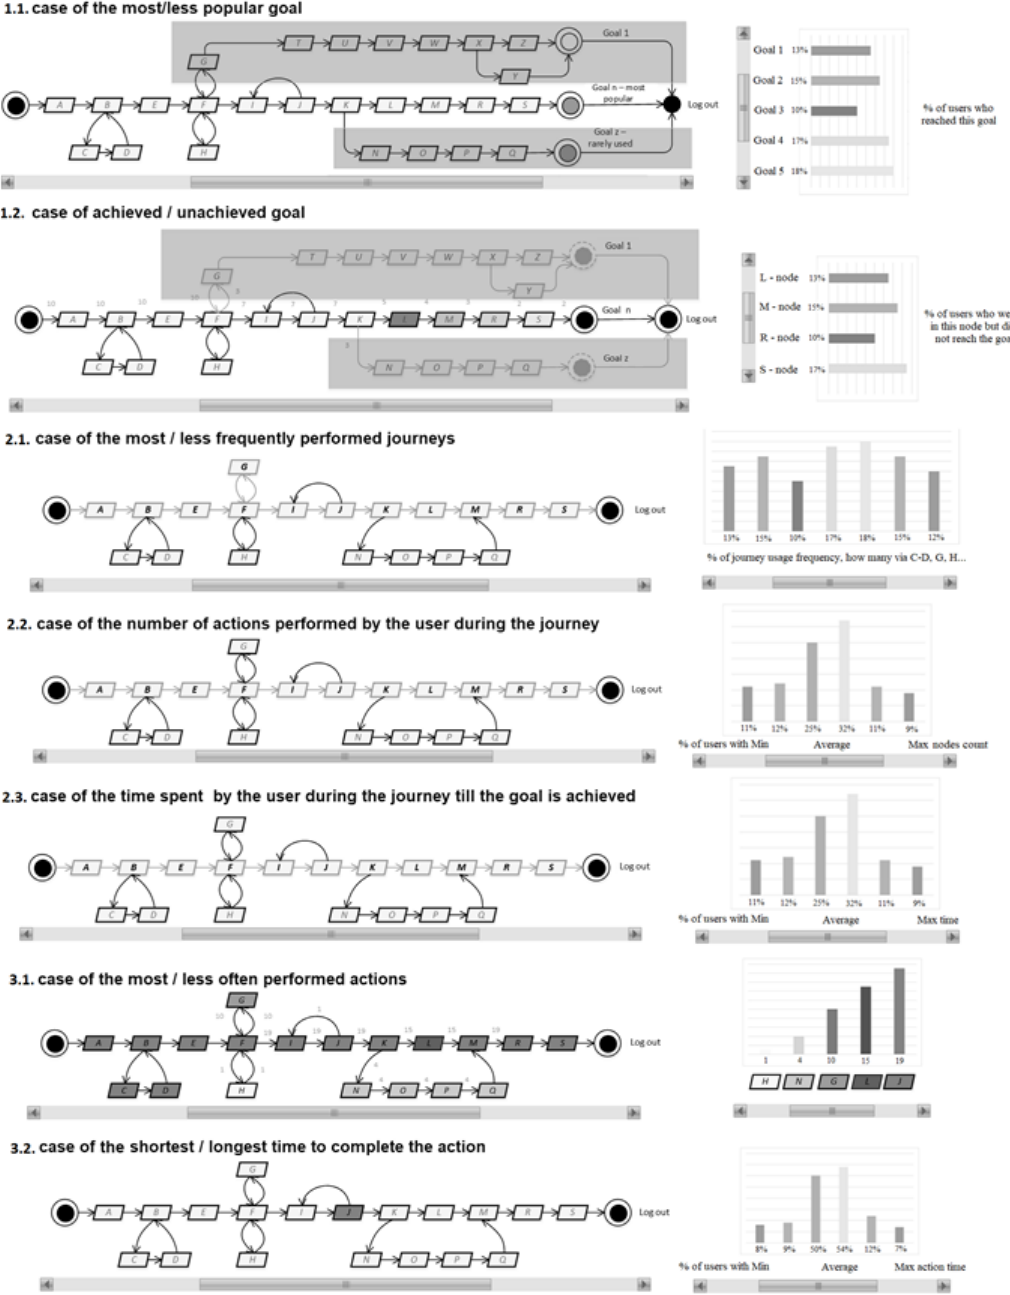
Fig. 4. Visualization of analysis cases